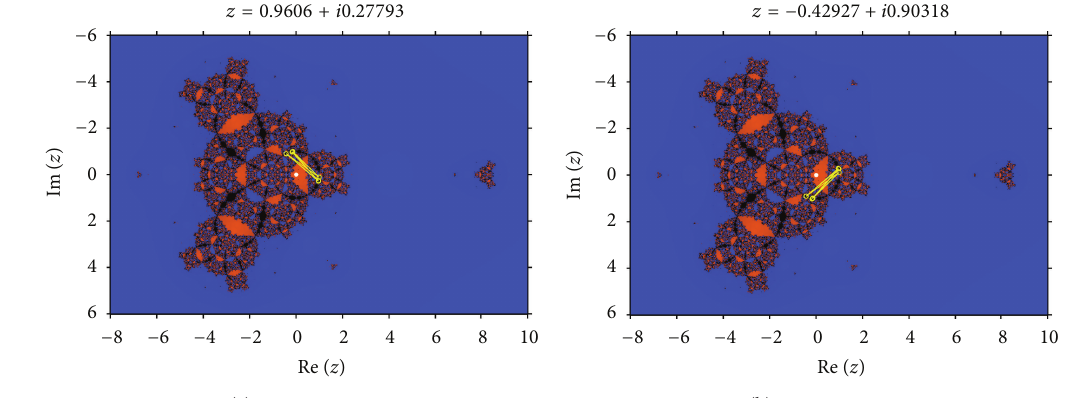
Figure 9: Stable behavior.